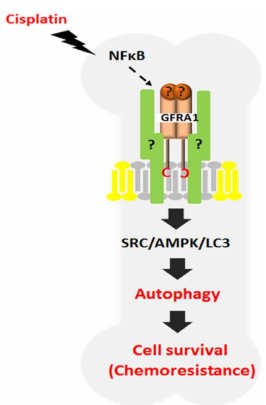
Figure 4. Schematic diagram for autophagy mediated by GFRA1 in cisplatin-resistant osteosarcoma. Cisplatin induces GFRA1 through NF κ B, and GFRA1 activates autophagy by SRC/AMPK signaling. Finally, GFRA1-mediated autophagy inhibits cisplatin-induced apoptosis, resulting in cell proliferation and